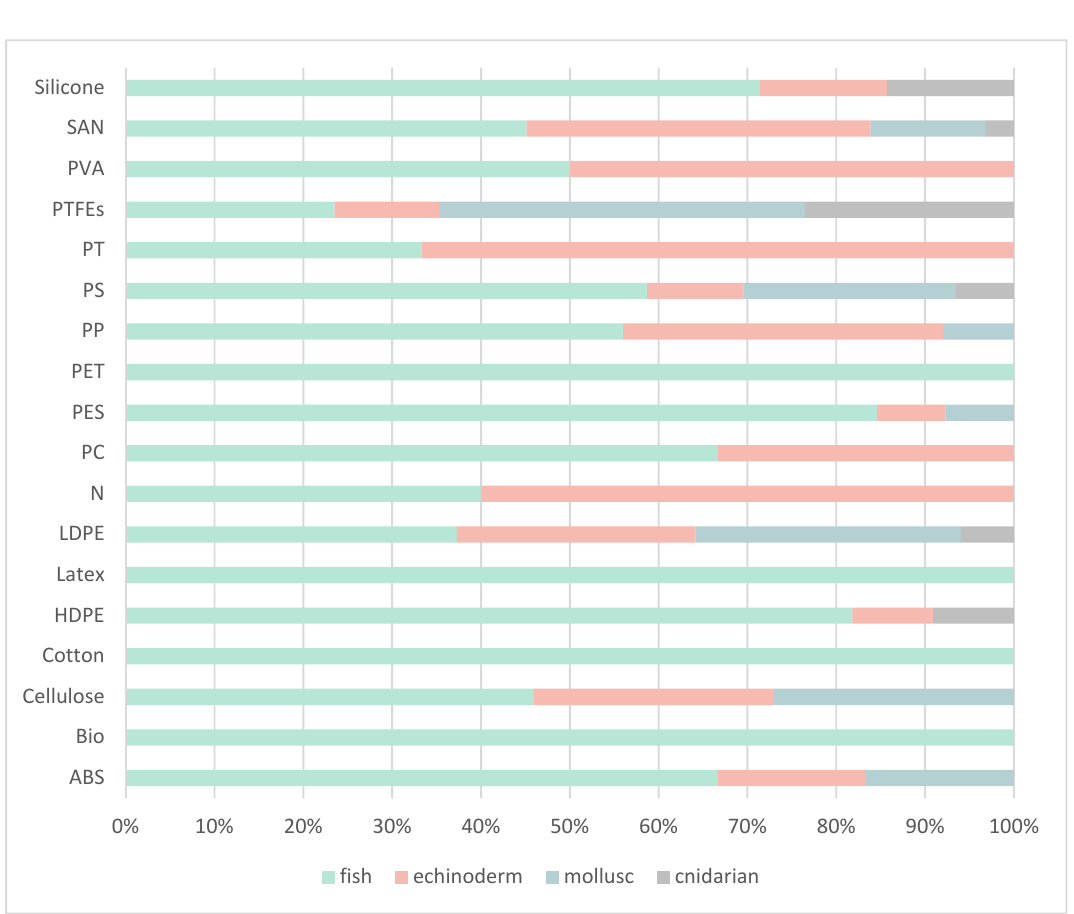
Figure 3. Bar graph of the polymers identified via ATR-FITR and micro-FTIR according to chemical composition: acrylonitrile butadiene styrene (ABS), biodegradable plastics (Bio), Cellulose, cotton, low-density polyethylene (LDPE), high-density polyethylene (HDPE), latex, nylon (N), polycarbonate (PC), polytetrafluoroethylene (PTFE), polyamide (PA), polyester (PES), polyethylene terephthalate (PET), polypropylene (PP), polystyrene (PS), styrene–butadiene rubber (SBR), paint (PT), poly (vinyl alcohol) (PVA), polyvinylidene fluoride (PVDF) and styrene–acrylonitrile (SAN).